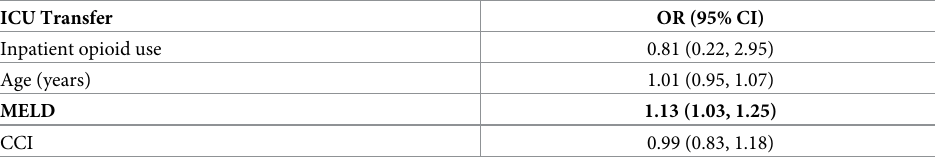
Table 9. Adjusted multivariable analysis of ICU